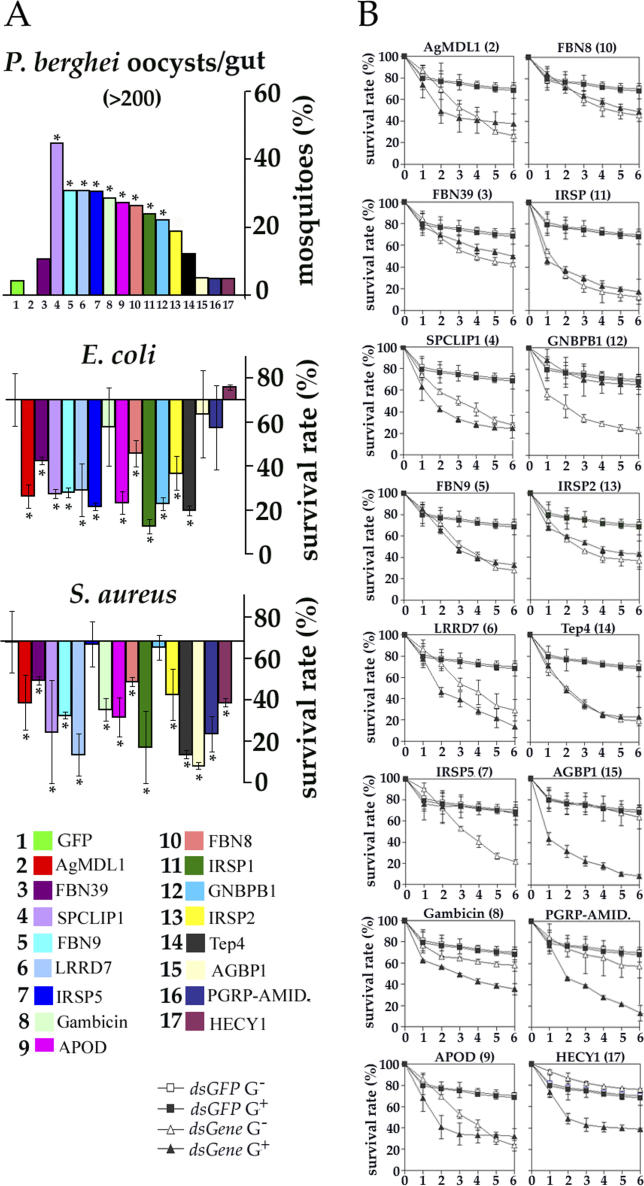
Comparison of Anti-Plasmodium and Antibacterial Activities for 16 Selected Immune Genes(A) Effect of gene silencing on P. berghei development, as described in Table S6. For ease of comparison, only the mosquito portions with the highest P. berghei oocyst numbers (>200) are presented. The effect of gene silencing on bacterial infection is presented as the mosquito survival at d 6 after challenge with E. coli and S. aureus. After 6 d, the survival rates stabilized and did not change significantly until age-related mortality ensued. The baseline survival rate was set to that of the challenged GFP dsRNA-treated control mosquitoes (~70%). Standard error bars with asterisks indicate the results of two-way analysis of variance, with p < 0.05 considered statistically significant. The gene names are numbered for ease of comparison.(B) Mosquito survival rates for each silenced gene after challenge with E. coli and S. aureus. The numbers in parenthesis correspond to the numbers in (A). Open squares, dsGFP control-treated mosquitoes challenged with E. coli; solid squares, dsGFP control–treated mosquitoes challenged with E. coli; open triangles, gene-silenced mosquitoes challenged with E. coli; and solid triangles, gene-silenced mosquitoes challenged with S. aureus. Standard error bars from three replicate experiments are included for each time point.